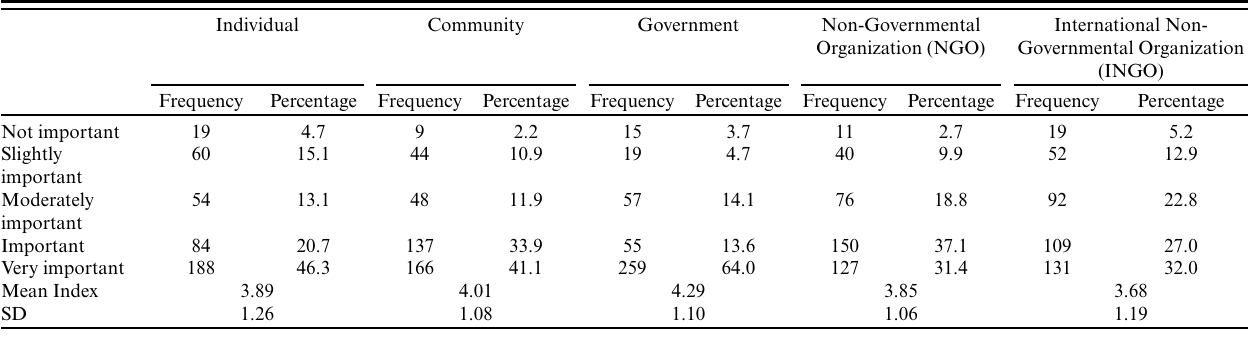
Table 3 . Importance of individual and organization in cultural ecosystem services management. Criteria of Assessment: 1 = Not important, 2 = Slightly important, 3 = Moderately important, 4 = Important, 5 = Very